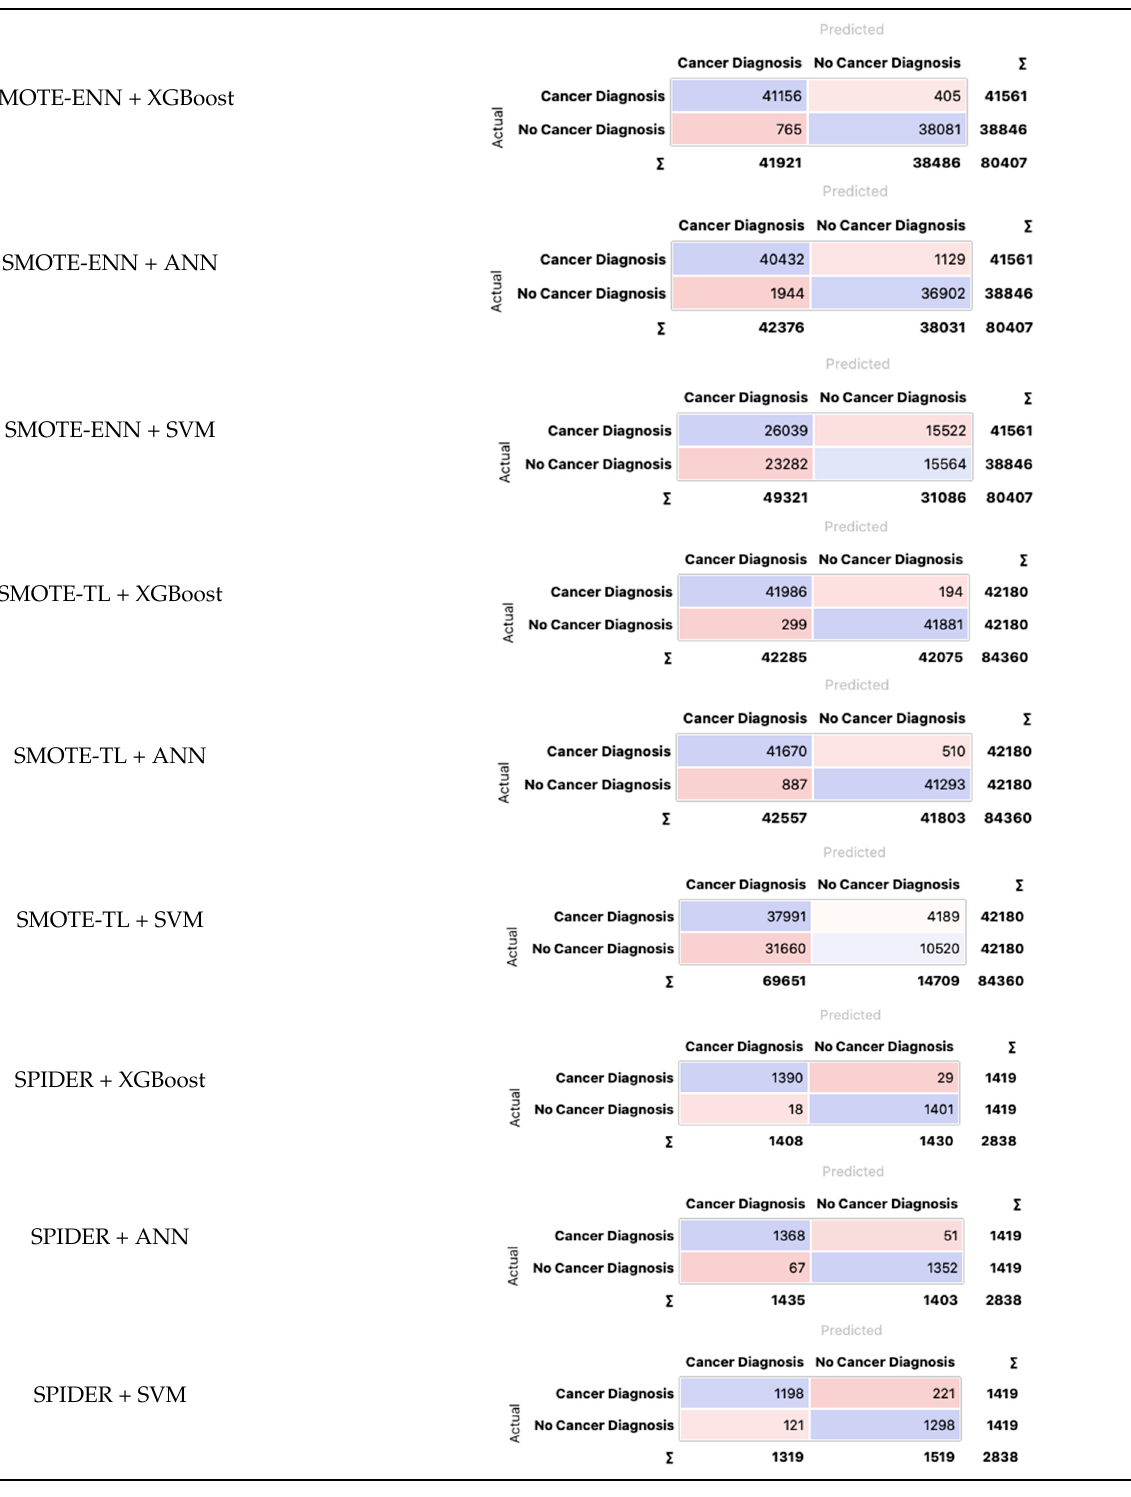
Table 11. Confusion matrix of the fusion model for datasets balanced using hybrid sampling techniques.